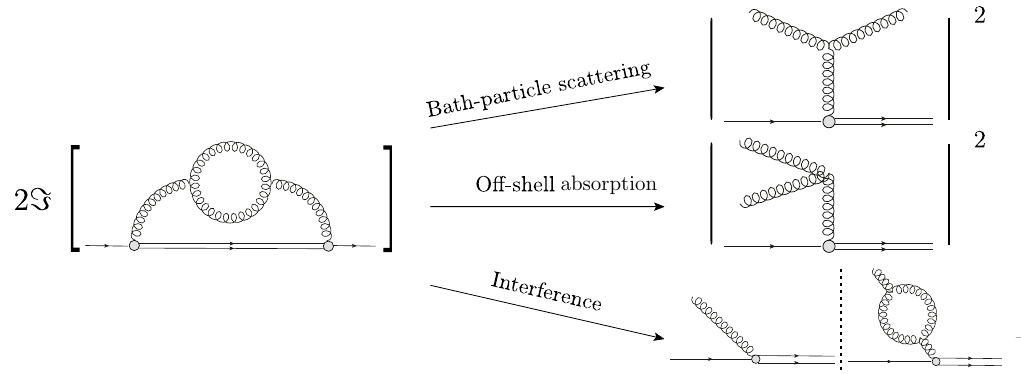
Figure 7. Decomposition of the imaginary part of the forward scattering amplitude of a singlet field with a gauge boson self-energy in terms of “cut” diagrams. When taken individually, these diagrams present singularities in the collinear limit, which only cancel after all terms are